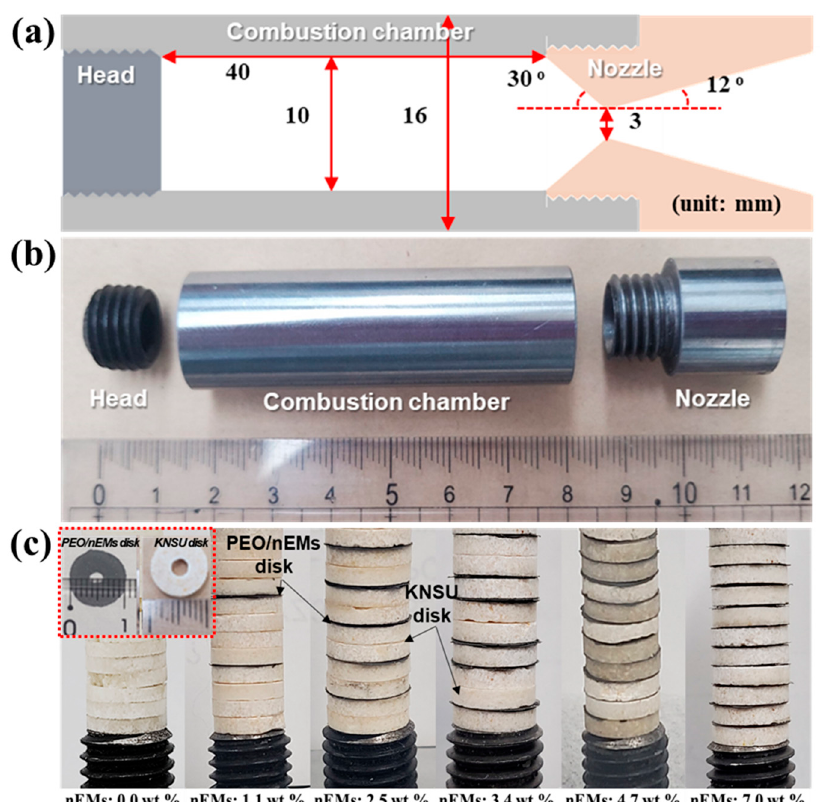
Figure 8. ( a ) Schematic and ( b ) photograph of small rocket motor. ( c ) Photographs of stacked KNSU- based disks inserted with different amounts of PEO/nEM-based 3D-printed disks. (Note: The pure amount of nEMs added in the KNSU/PEO/nEM-based CSPs is presented under each photograph.).